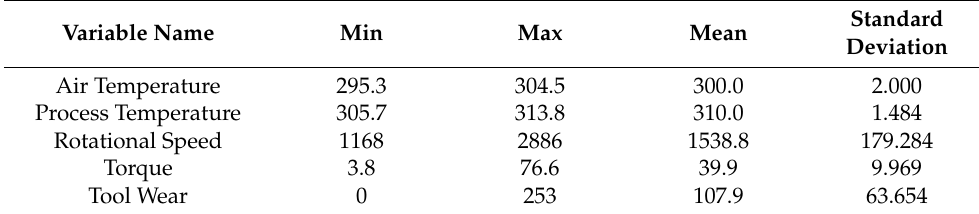
Table 3. Statistical properties of continuous